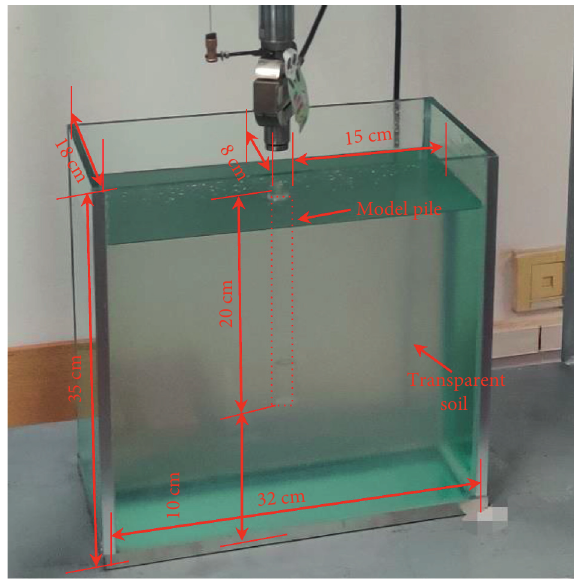
Figure 5: Layout of the model box and pile soil.